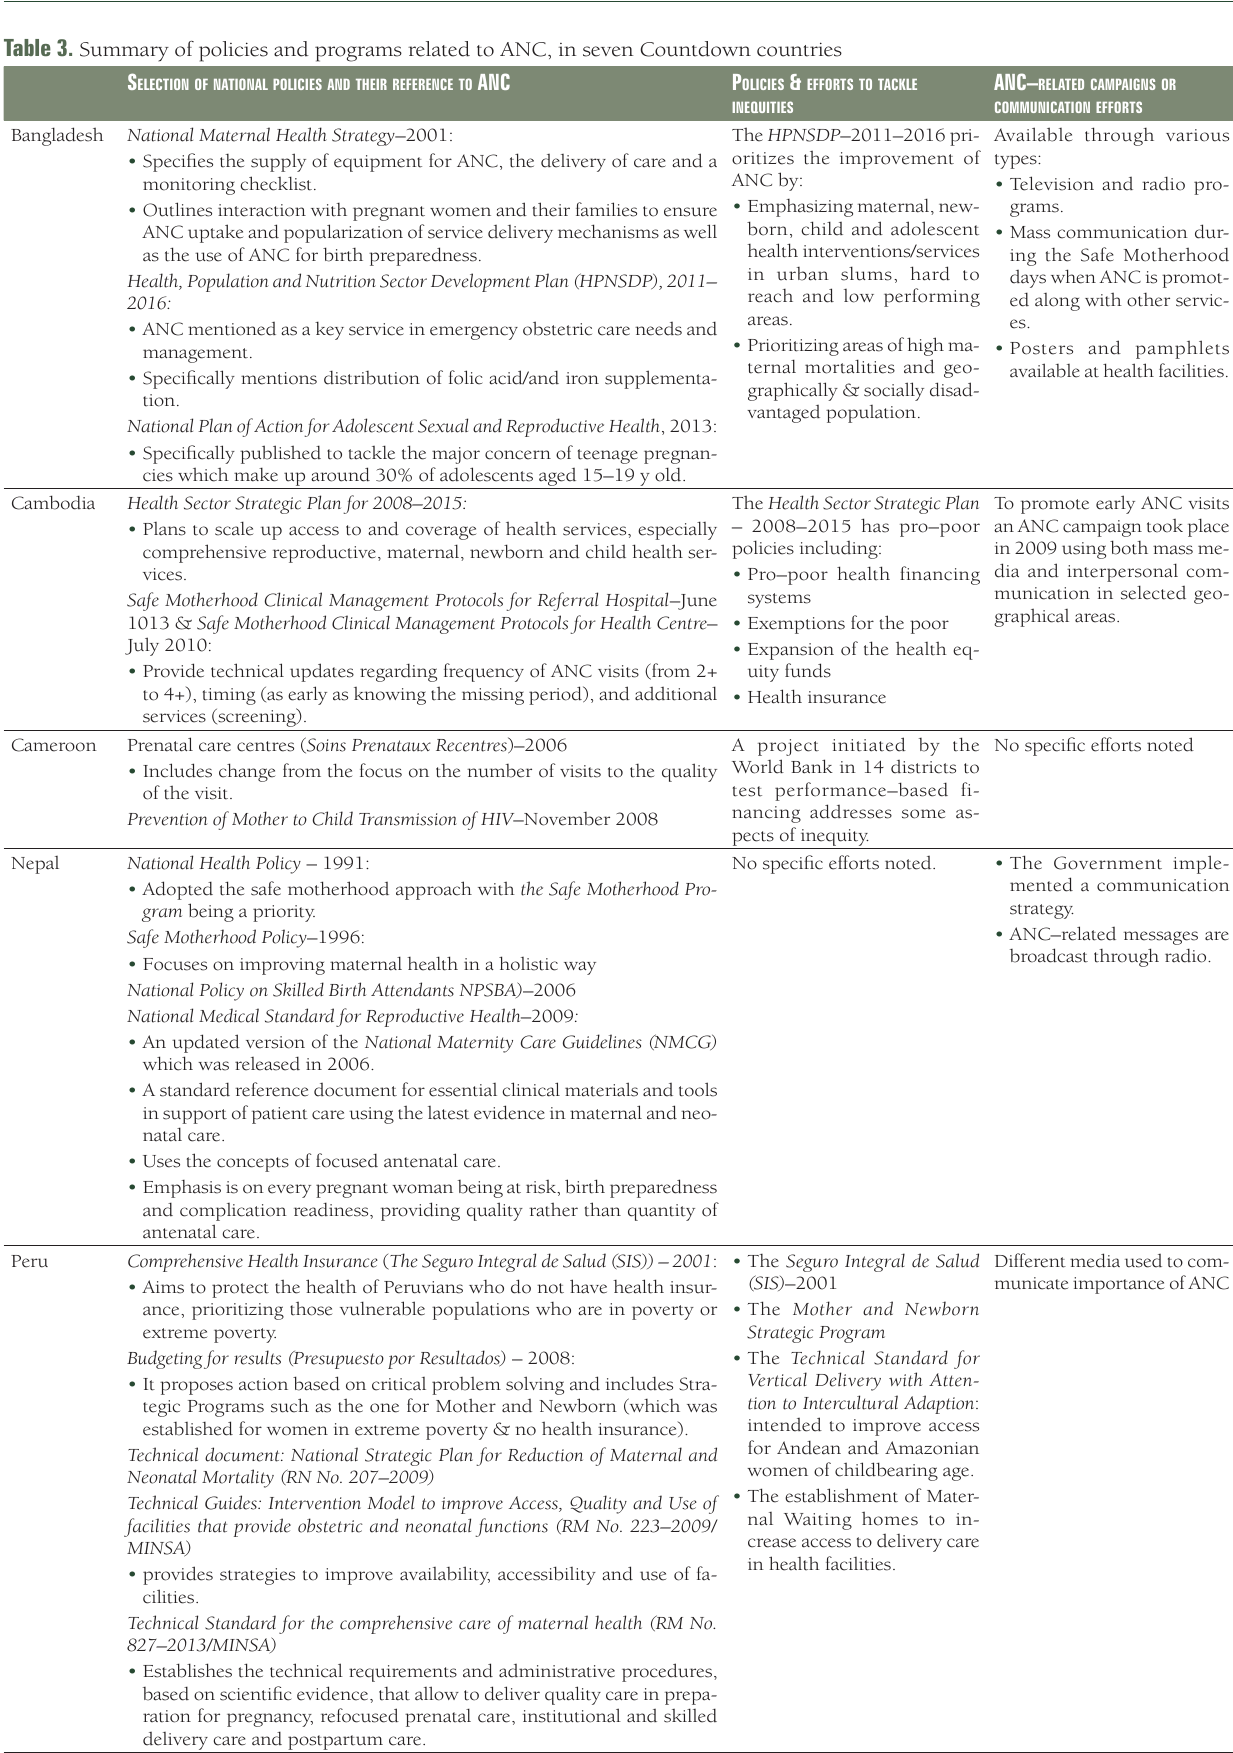
Table 3. Summary of policies and programs related to ANC, in seven Countdown